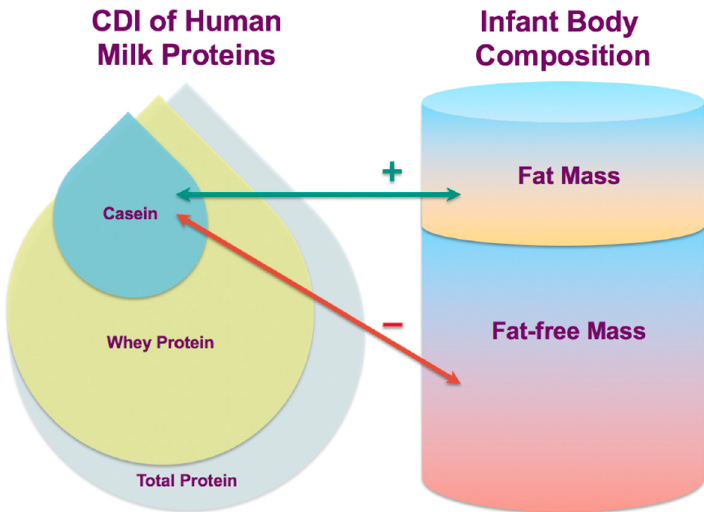
Figure 4. Possible lactocrine programming of the infant body composition during the first year of life as researched. Green arrow indicates positive associations of calculated daily intakes (CDI) of casein with measured body composition parameters and red arrow—negative associations.